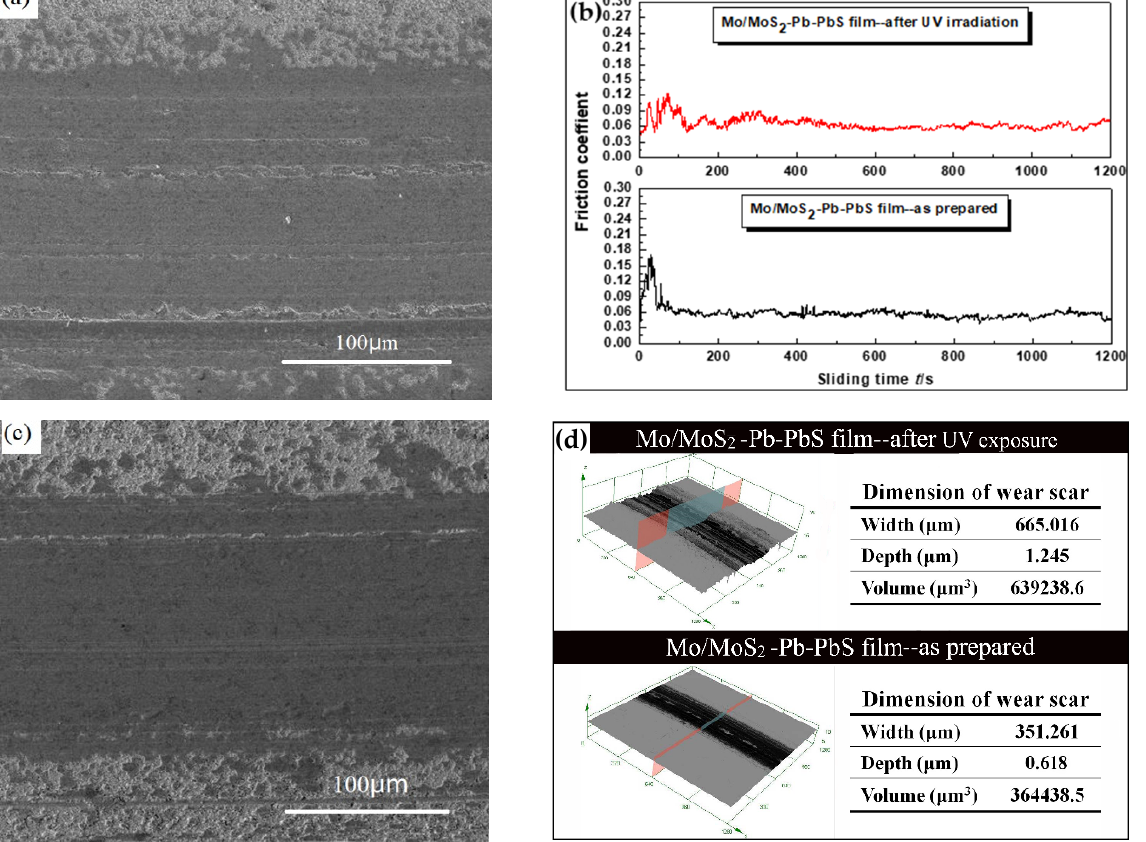
Figure 4. The tribological properties Mo/MoS 2 -Pb-PbS composite film before and after UV radiation; ( a ) wear scar morphology without UV radiation;( b ) friction coefficient curve; ( c ) wear scar morphology after 40 h UV radiation; ( d ) Three-dimensional wear scar morphology before and after UV radiation.